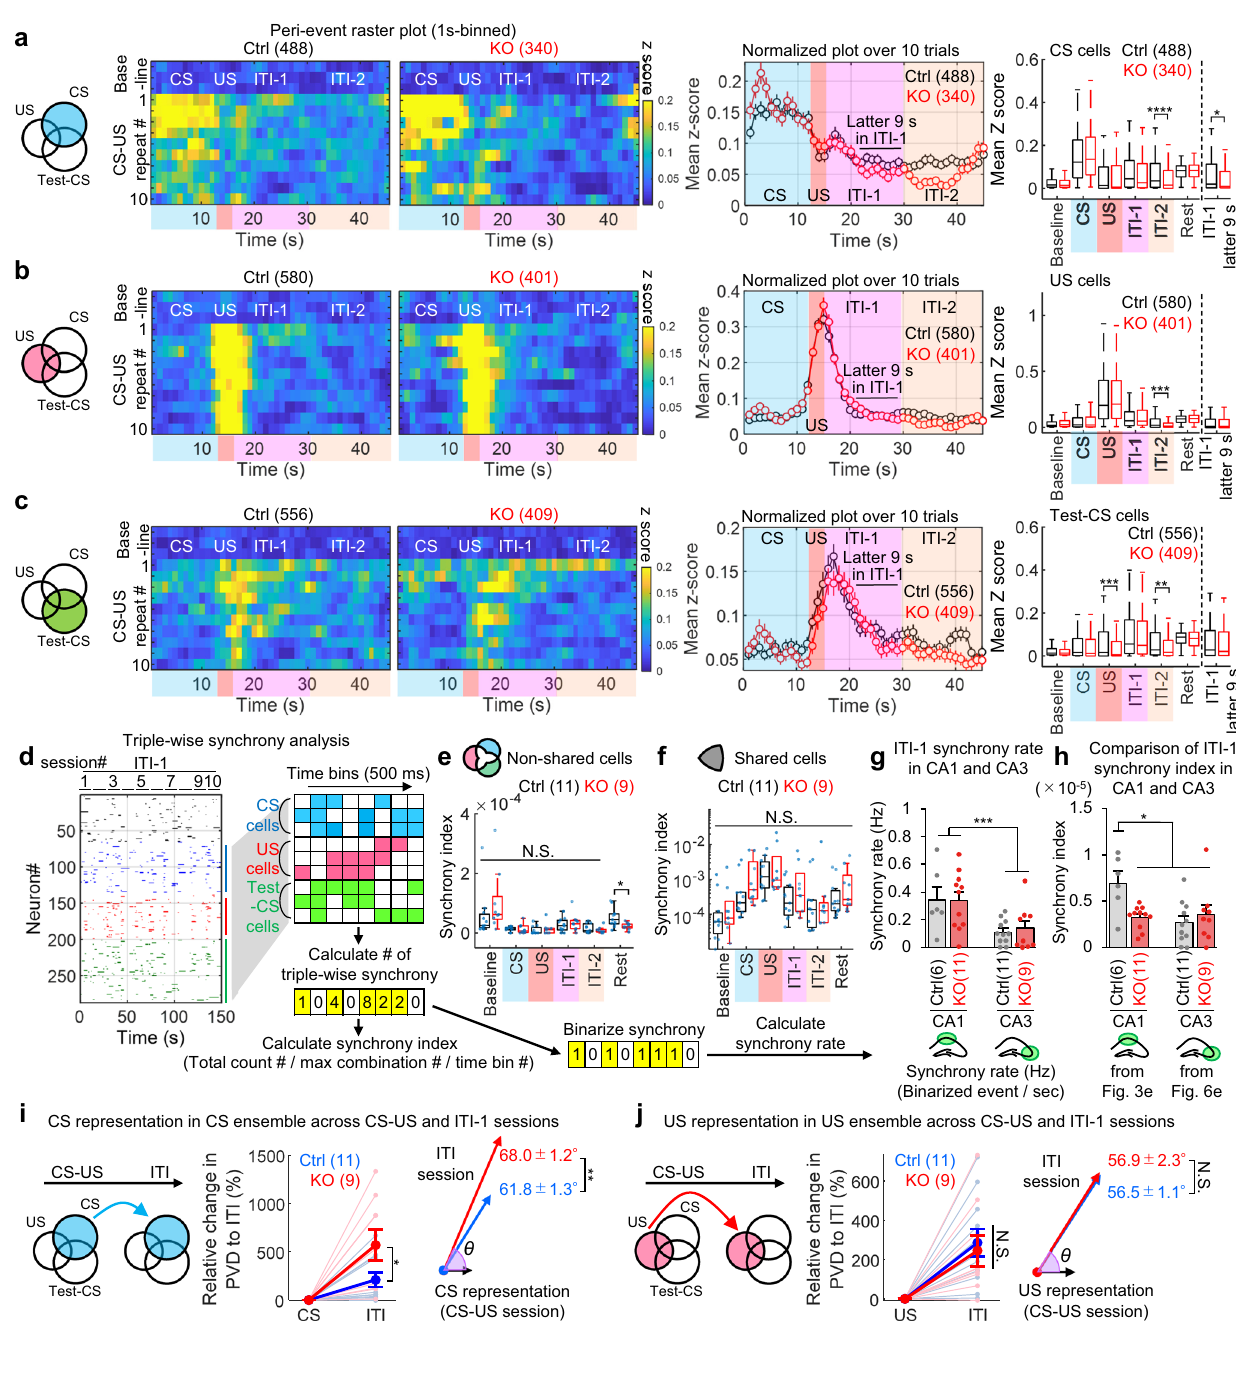
For the in vivo Ca2 + imaging experiment, a recombinant Adeno- Associated Virus (AAV) vector encoding AAV9-CaMKII::G-CaMP7 (Titer: 9.4 × 10 12 vg/mL) after 40-fold dilution with phosphate- buffered saline (PBS) (T900; Takara Bio, Inc., Japan) was used 45 . For optogenetic silencing during the training session, AAV encoding AAV5-CBA-FLEX-ArchT-tdTomato, a gift from Edward Boyden (Titer: 1.3 × 1013 GC/mL) (Addgene viral prep # 28305- AAV5, USA) after 10-fold dilution with PBS was used. For optoge- netic silencing during the test session, lentivirus (LV) encoding CaMKII-FLEX-eArchT3.0-EYFP, a gift from Karl Deisseroth